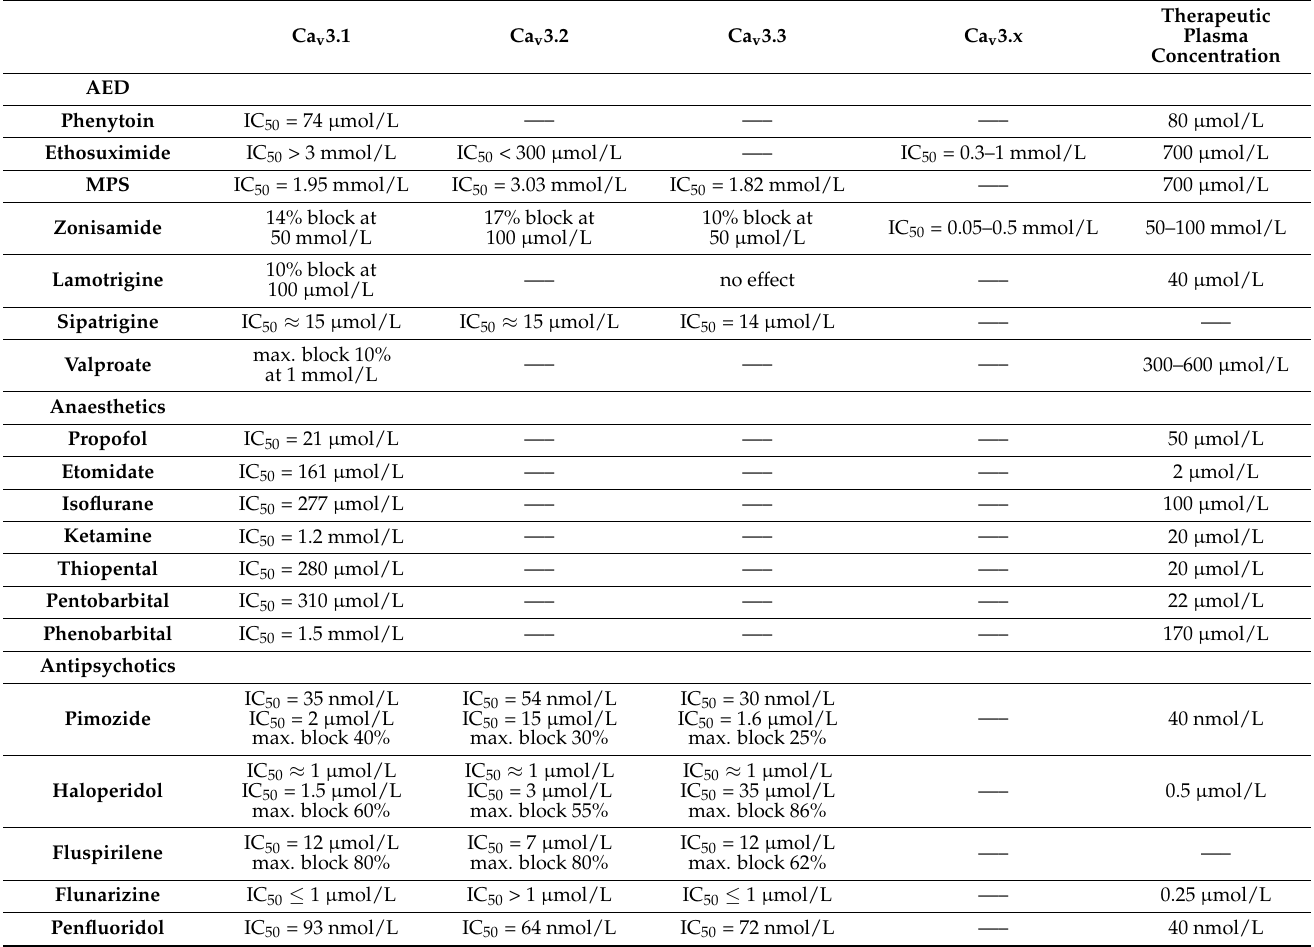
Table 2. Effects of antiepileptic drugs, general anesthetics, and antipsychotics on Ca v 3.1, Ca v 3.2, and Ca v 3.3 VGCCs. This table lists a selection of AEDs, anesthetics, and antipsychotics that were reported to exert antagonistic effects on Ca v 3.x T-type VGCCs. In addition, IC 50 values are listed for the individual drugs, together with drug-related therapeutic plasma concentrations. Some experimental and licensed CCBs, e.g., mibefradil, amlodipine, nimodipine, isradipine, nifedipine, and verapamil, exhibit IC 50 values for Ca v 3.1–3.3 in the micromolar range, which is above the therapeutic plasma concentrations. Note that blockage of Ca v 3.x VGCCs is known to be state-dependent for many drugs (e.g., for ethosuximides or MPS), with higher affinity for the inactive state. Thus, the membrane potential (or holding potential) has a tremendous impact on steady-state inactivation and IC 50 values, which needs to be considered when interpreting IC 50 values and therapeutic plasma concentrations. Clearly, most of the drugs listed here, particularly AEDs, have a multitarget character and modulate other voltage-gated ion channels or ligand-gated ionotropic and metabotropic ion channels as well [274]. For references, see [105,115,119,272,273,275–285]. Therapeutic Ca v 3.1 Ca v 3.2 Ca v 3.3 Ca v 3.x Plasma